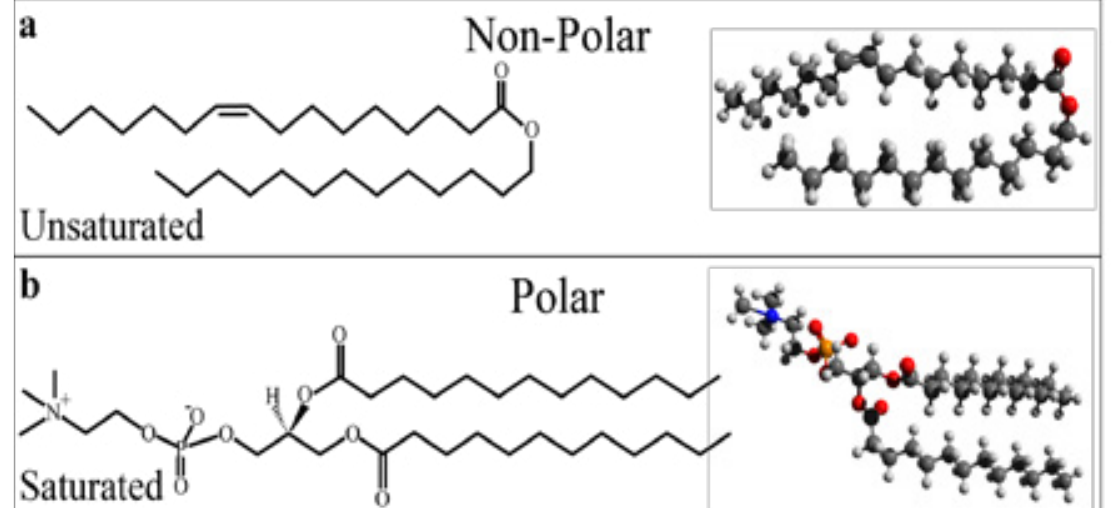
Figure 1: Non-polar and polar lipid structures which represent lipids found within meibum. a . Non-polar, unsaturated wax monoester. b . Polar, saturated phosphatidylcholine. Line-bond structures are shown on the left whereas the ball-and-stick model is shown on the right. ( The Line-bond structures were obtained from Lipid Metabolites and Pathway Strategy (LIPID MAPS) and the ball-and- stick structures were rendered with Avogadro 3D molecular structure editor)